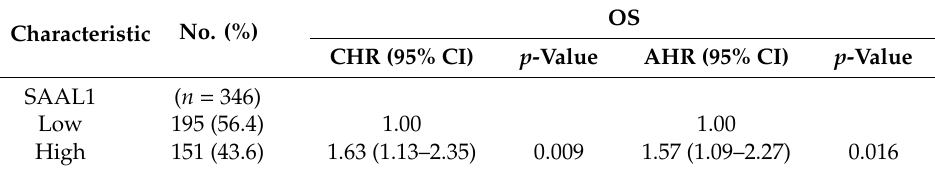
Figure 1. The expression level of SAAL1 increases in HCC tumor tissues and correlates with poor overall survival in HCC patients. ( A ) Analysis of the expression level of SAAL1 in HCC patients using TCGA and GENT databases. ( B ) Kaplan-Meier survival analysis of HCC patients according to SAAL1 RNAseq data retrieved from TCGA dataset. Table 1. Univariate and multivariate Cox’s regression analysis of SAAL1 gene expression for overall survival of 346 patients with HCC.